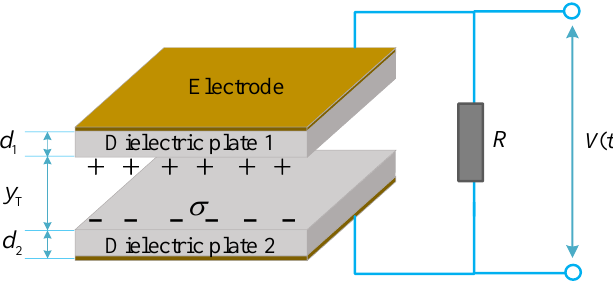
Figure 7. The schematic design of the tribo-pair of TENG device.